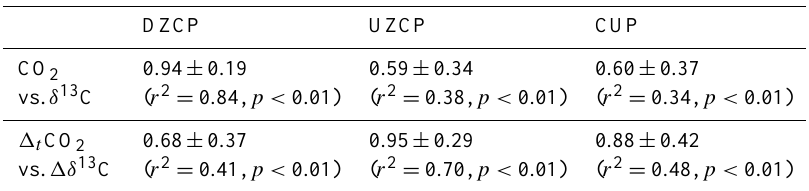
Table E3. Linear regression coefficients that describe the relationship between changes in CO 2 , (cid:49) t CO 2 , and δ 13 C at BRW during the overlapping time span of the data